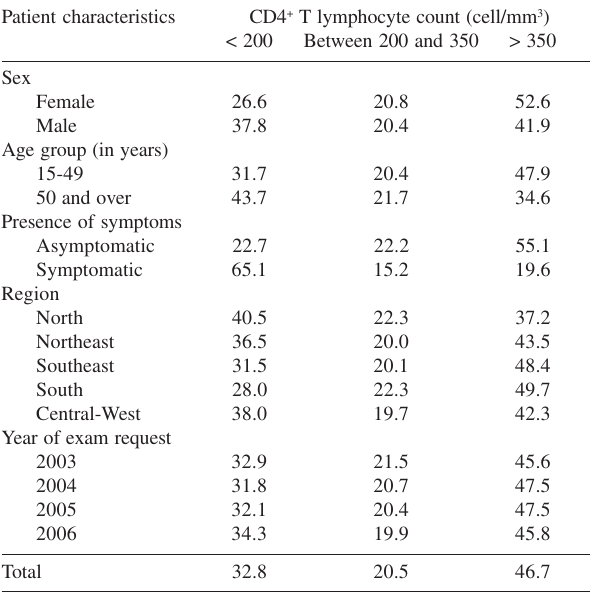
Table 2 - Distribution (%) of CD4 + T lymphocyte counts among treatment-naïve patients by sex, age group, presence of symptoms, region of residence and year of exam request. Brazil,